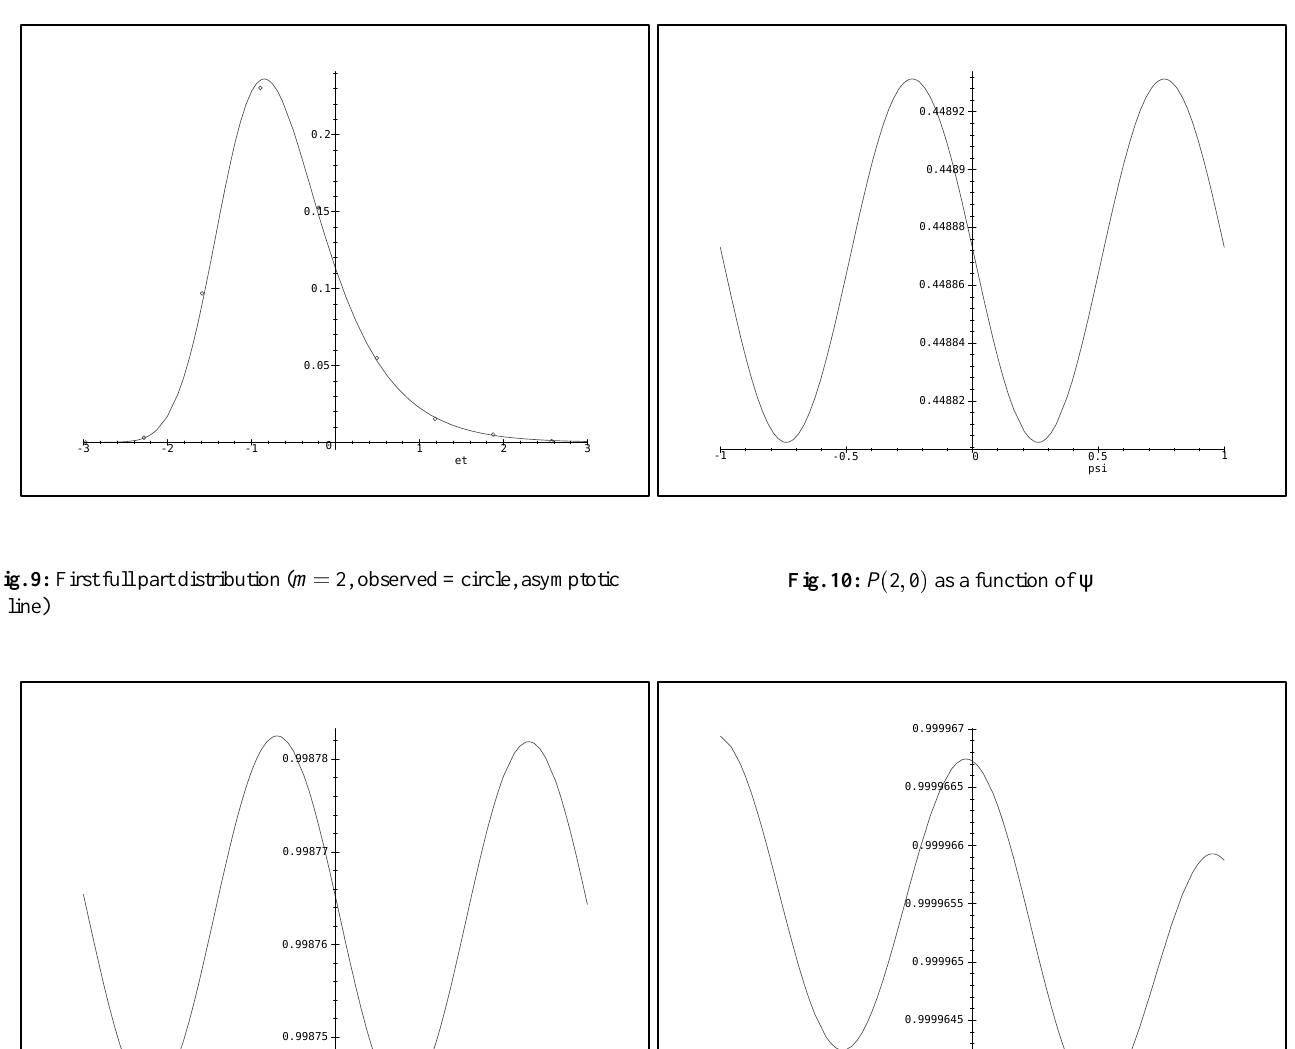
Fig. 11: (cid:229) 3